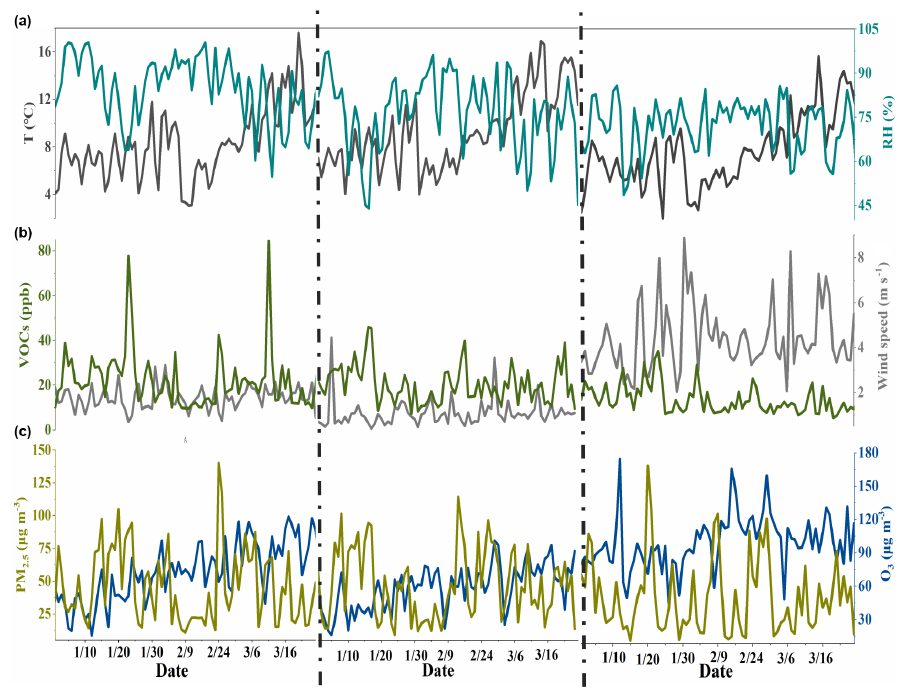
Figure 1. Time series of temperature ( T ), relative humidity (RH), wind speed, VOC category, PM 2 . 5 and O 3 at the (a) JS, (b) PD and (c) QP sites.